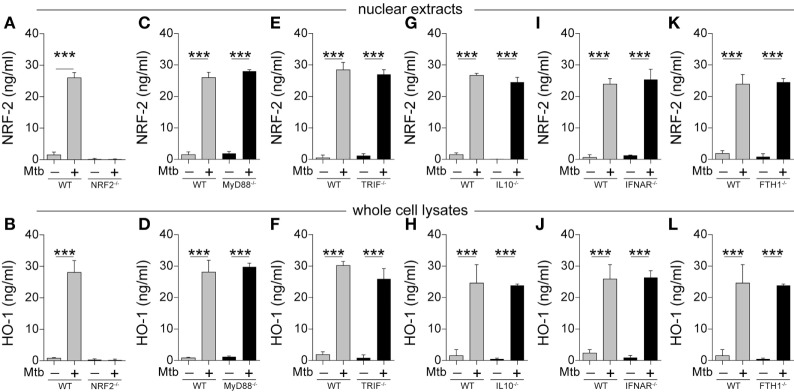
Mycobacterium tuberculosis (Mtb) induction of heme oxygenase-1 (HO-1) protein expression in mouse macrophages is independent of multiple signaling pathways linked to innate immunity in tuberculosis. (A–L) Bone marrow-derived macrophages from mice genetically lacking expression of the indicated genes or their respective wild-type (WT) controls were infected with H37Rv Mtb (multiplicity of infection: 3) for 24 h. Protein expression of nuclear factor erythroid-derived 2-like 2 (NRF-2) and HO-1 was quantified in nuclear extracts and whole cells lysates, respectively, by ELISA. Bars and lines represent mean and SEM, respectively. Data are from at least three independent experiments using triplicate biological samples. Data were compared using the Wilcoxon matched-pairs test (*p < 0.05, **p < 0.01, ***p < 0.0001). MyD88, myeloid differentiation primary response gene 88; TRIF, TIR domain-containing adapter-inducing interferon-β; IL-10, interleukin-10; IFNAR, interferon alpha and beta receptor subunit 1; FTH1, ferritin heavy chain 1.